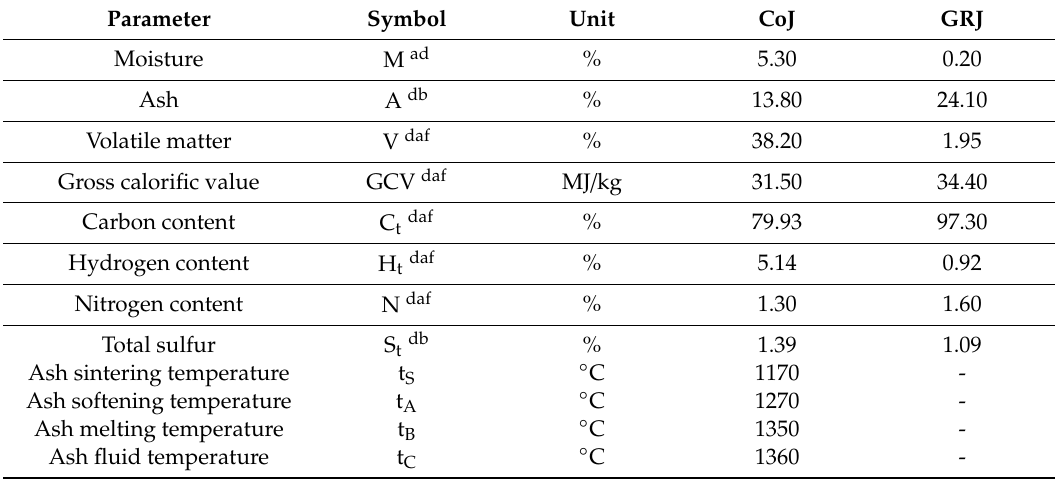
Ash sintering temperature t